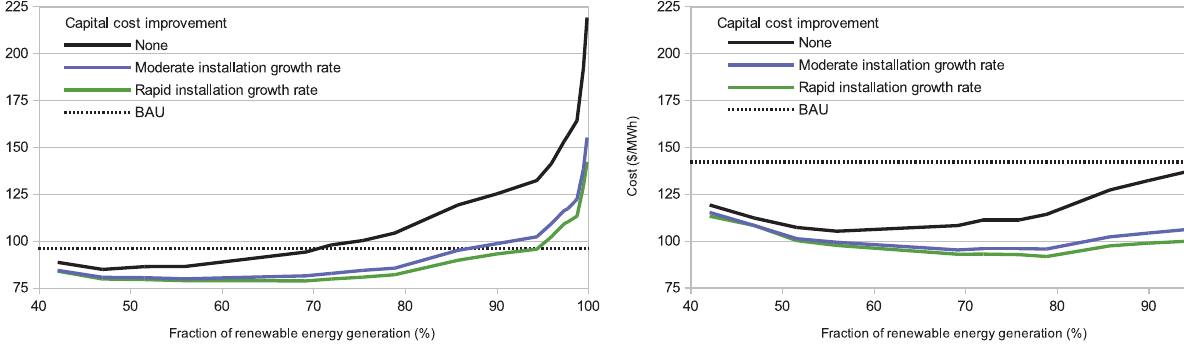
Fig. 5. Cost of partial renewable energy generation scenarios compared to business as usual (BAU) case (dashed line) with a $70 per tonne carbon price. Renewable technologies used are wind, solar photovoltaic and distributed battery storage. Black line is no cost improvement over time, blue line is global cost improvement rates and moderate installation growth rates. Green line is global cost improvement rates and rapid installation growth rates. Cost is in Australian